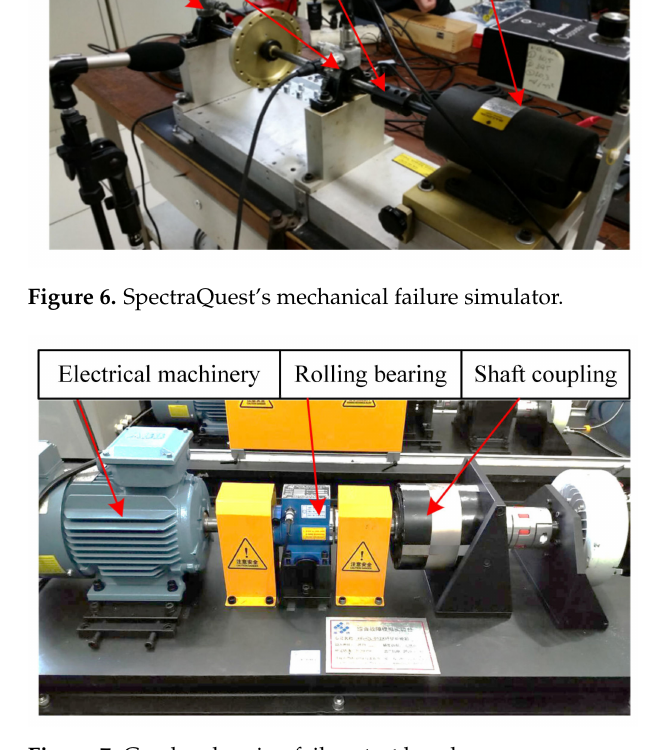
Figure 7. Gearbox bearing failure test bench.